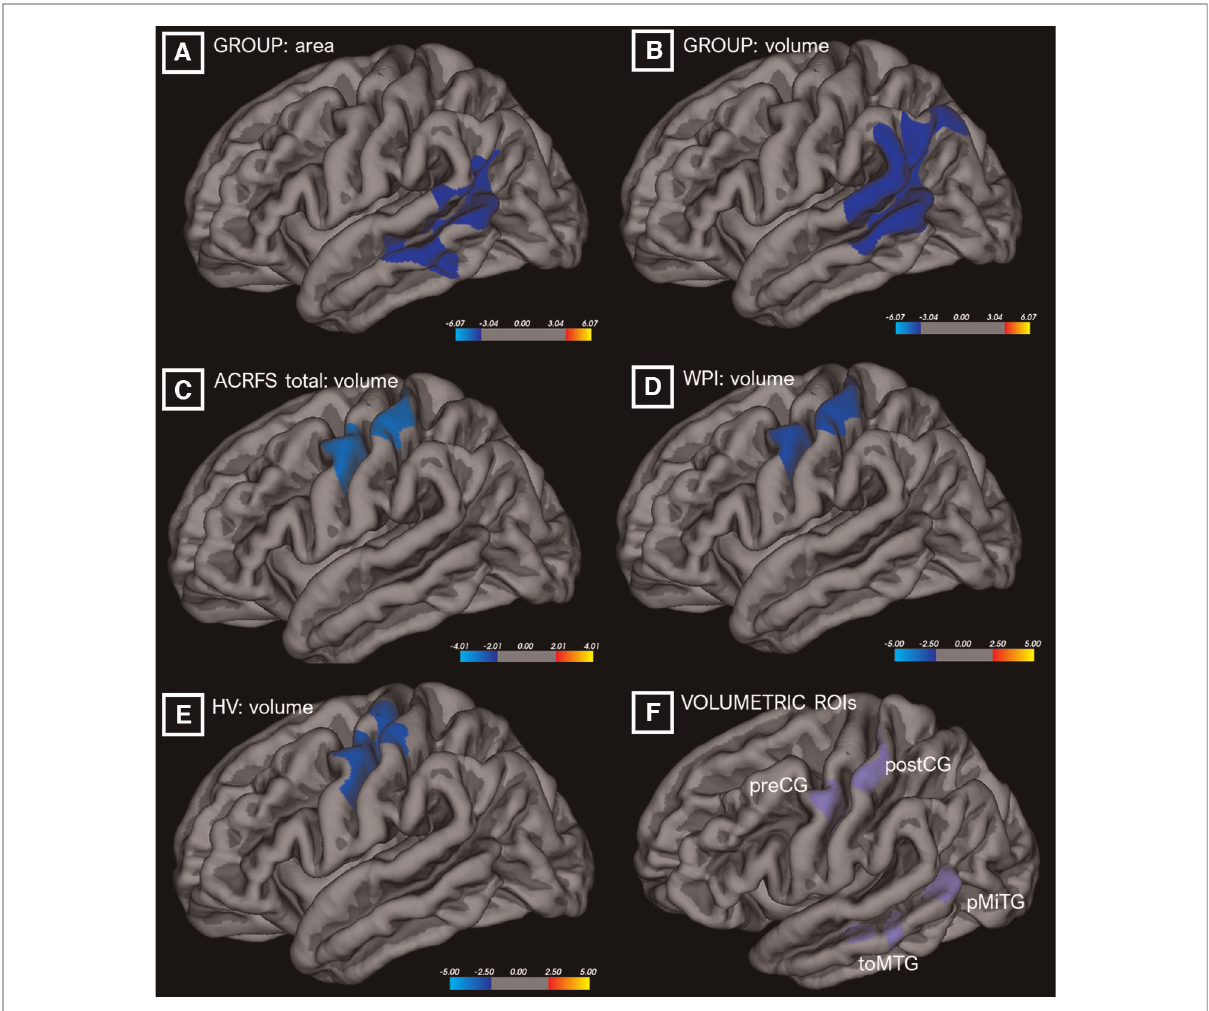
FIGURE 1 Differences in cortical surface area ( “ area, ” A ) or grey matter volume ( “ volume, ” B – E ) as a function of group or ACRFS scores, from cluster-based morphometric analyses. ROIs from these analyses ( F ) were incorporated into the connectivity work fl ows. ACRFS, American College of Rheumatology Fibromyalgia Survey; HV, Pennebaker Hypervigilance score; WPI, ACRFS Widespread Pain Index